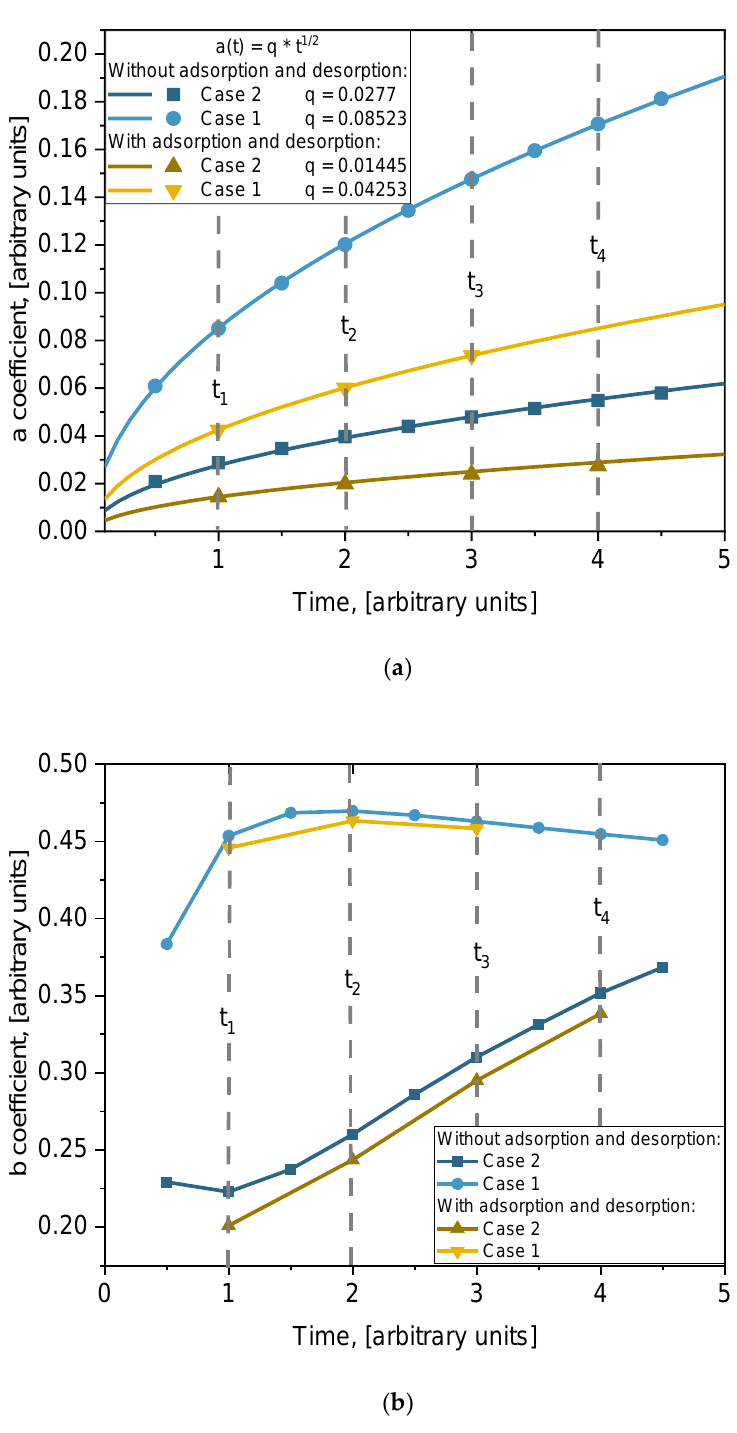
Figure 9. Dependencies on time (points) of coefficients ( a ) a and ( b ) b from Equation (8) (values from (Table 3)) for Case 1 and Case 2 with and without adsorption/desorption processes. In ( a ) lines are fitting of points with function q t 1/2 , and q values are indicated in ( a ).